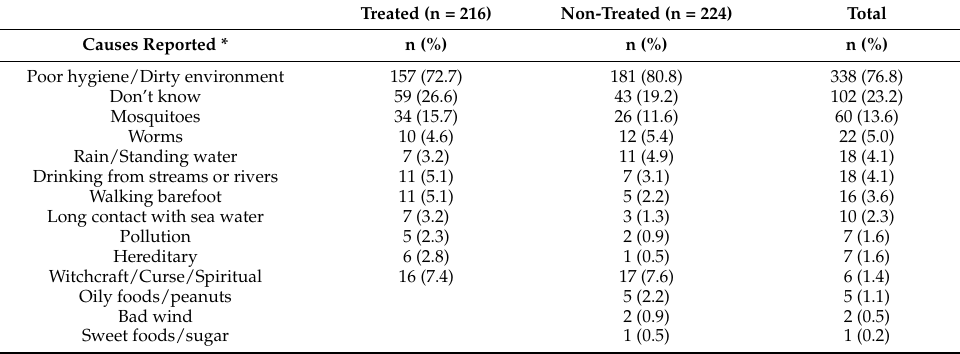
Table 3. Causes of Lymphatic Filariasis disease reported